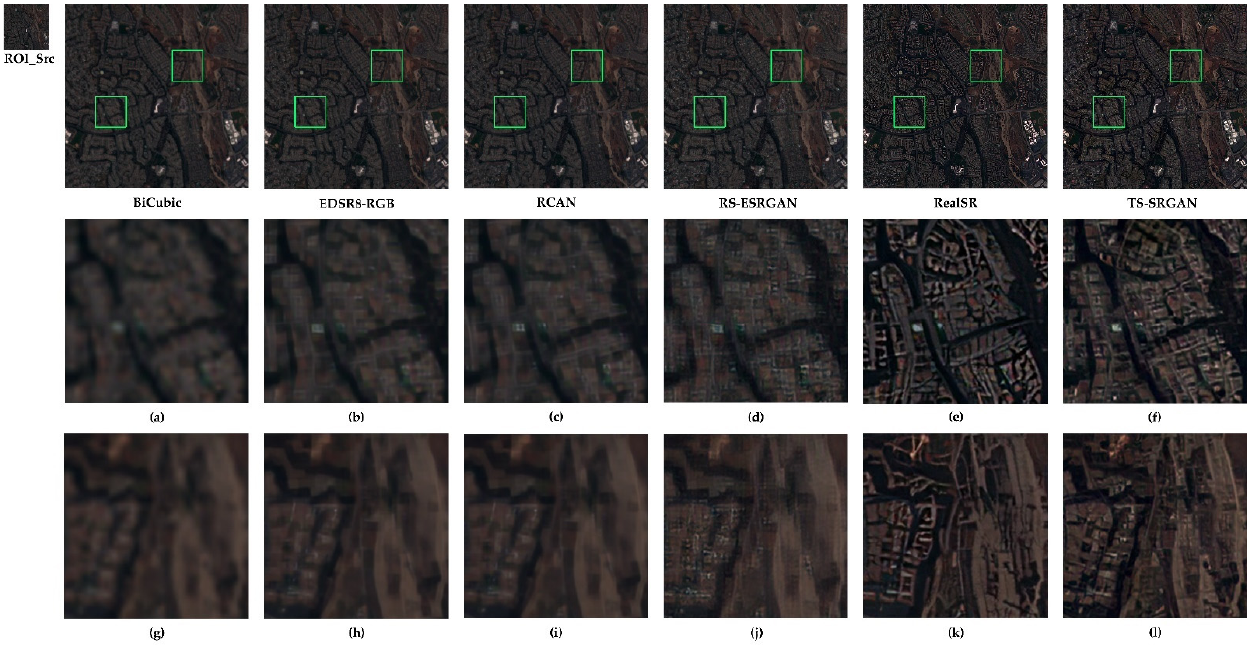
Figure 19. Comparison of visual effects of the generated images of the region containing residential houses. NR-IQA of images (NIQE, BRISQUE, PIQE): BiCubic (6.26, 53.22, 100.00), EDSR8-RGB (4.82, 45.85, 74.28), RCAN (3.96, 45.61, 71.41), RS-ESRGAN (3.08, 22.47, 20.85), RealSR (3.12, 27.19, 15.42), TS-SRGAN (2.32, 18.27, 13.99). The subfigures ( a – l ) in the figure represent an enlarged view of the local details in the green boxes in the generated image.